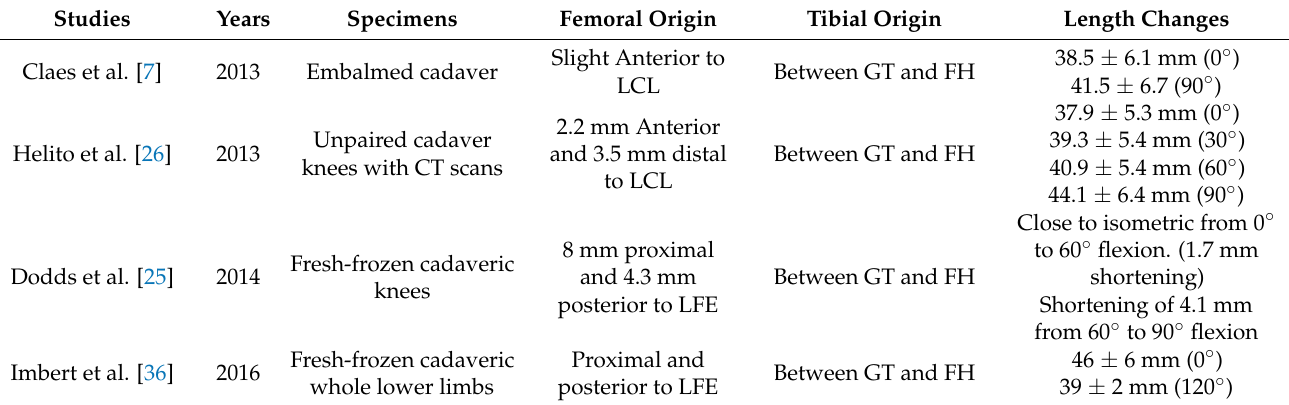
Table 2. Summary of length change patterns of the anterolateral ligament during knee flexion in the biomechanical